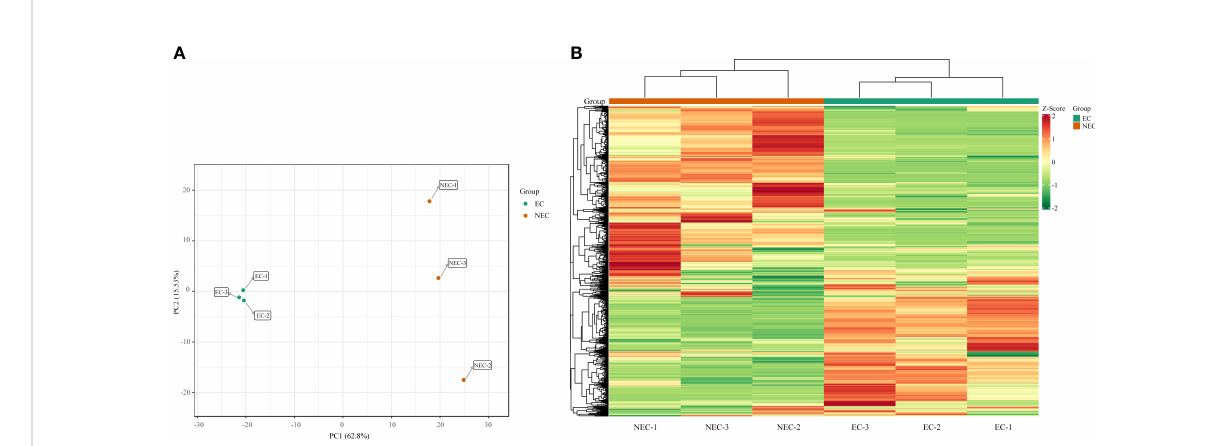
FIGURE 2 Principal component analysis (PCA) score plots and heat map of metabolite pro fi le. (A) PCA score plots with each point representing an independent biological replicate; (B) Heatmap of metabolite abundance of EC and NEC according to hierarchical cluster analysis, where green, yellow, and red indicate low, intermediate, and high accumulation,